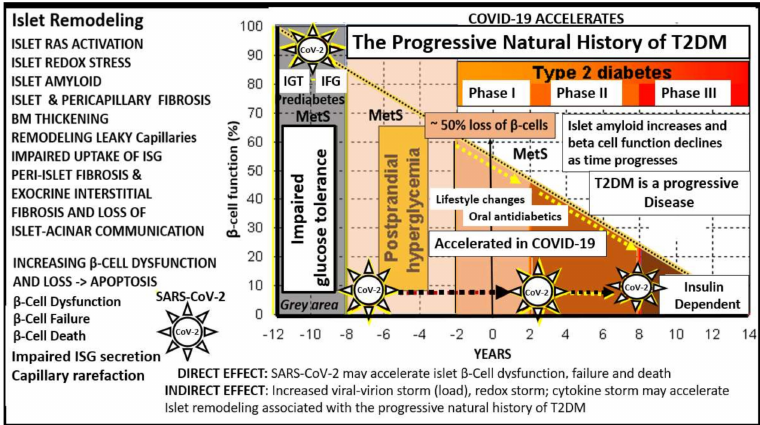
Figure 2. T2DM is a progressive disease with multiple stages and phases in humans. At the time of diagnosis of T2DM, patients may already have a 50% reduction in β -cell function. As one moves through the various stages / phases, there is a progressive loss of β -cell function, while concurrently there is increased deposition of amylin-derived islet amyloid and islet fibrosis (islet remodeling—isletopathy). When SARS-CoV-2 (spiked icon) binds to the ACE2 receptor of β -cells and vascular EC / pericyte, cells there will be a detrimental increase in the ratio of the ANG II–ACE2–MasR axis. COVID-19 is known to be associated with a systemic and even local cytokine storm in addition to a redox storm (excessive oxidative stress—reactive oxygen and nitrogen (nitrosative stress) species (RONS)) and could be possibly based on the viral virion (viral load) storm associated with viremia. Therefore, COVID-19 could accelerate the natural history of T2DM. This image is based on a classic graph by Lebovitz HE. Diabetes Rev. 1999, 7, 139–153 and Hayden MR et al. JOP. J. Pancreas (online) 2002, 3(5),